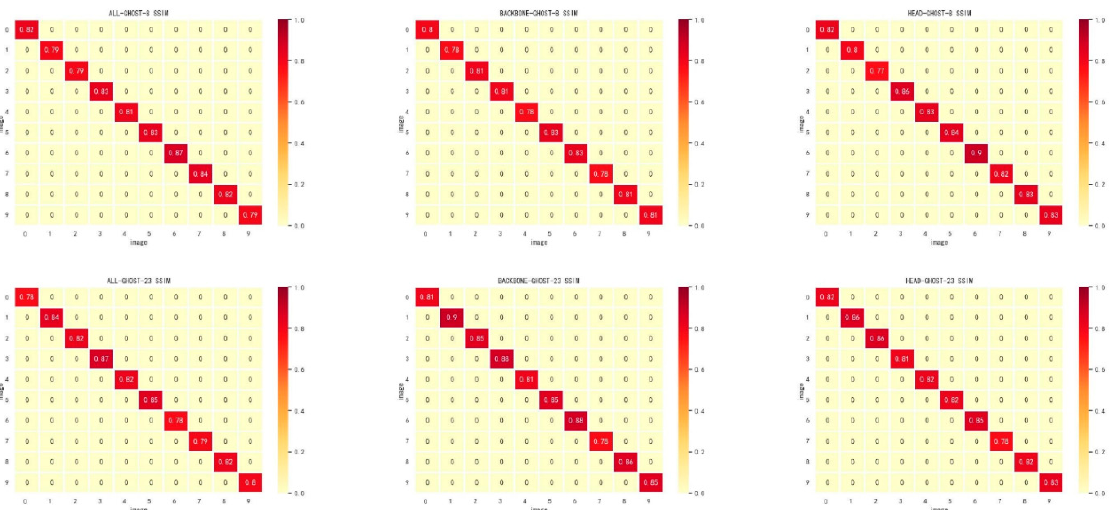
Figure 7. Heatmaps of SSIM compared to original images. ALL-GHOST-8 and ALL-GHOST-23 means the output of the eighth and the twenty-third layer in which the Ghost module is added both in the head and backbone. BACKBONE-GHOST-8 and BACKBONE-GHOST-23 means the output of the eighth and the twenty-third layer in which the Ghost module is added in backbone only. HEAD-GHOST-8 and HEAD-GHOST-23 means the output of the eighth and the twenty-third layer which Ghost module is added in head only.